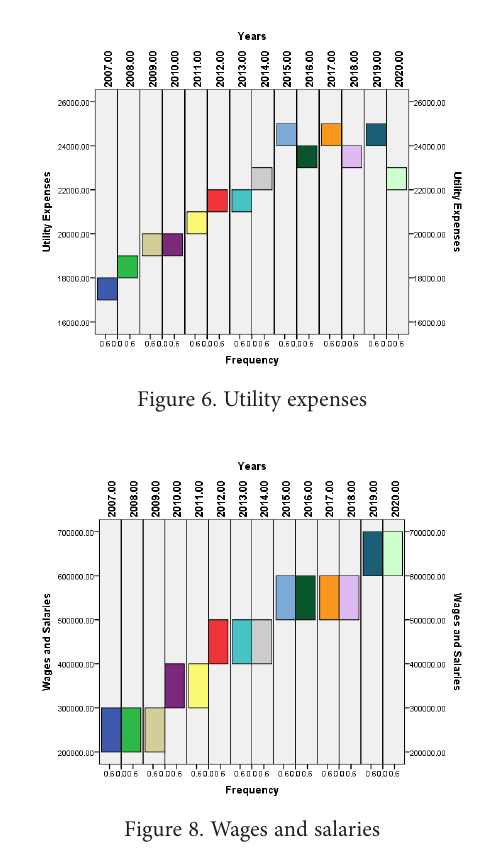
Figure 4. Goods and services Figure 5. Capital expenditures